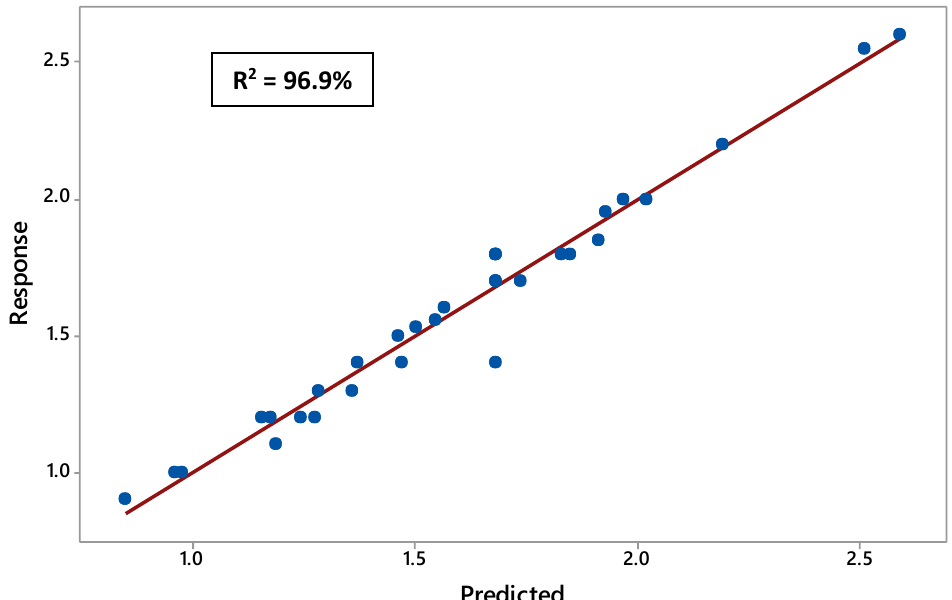
Figure 4: Predicted vs. real response values of R a surface roughness